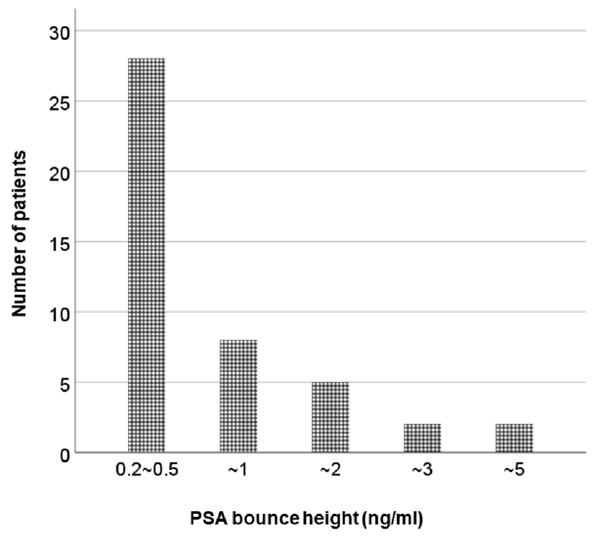
Figure 3. The PSA bounce magnitude. PSA, prostate-specific antigen.